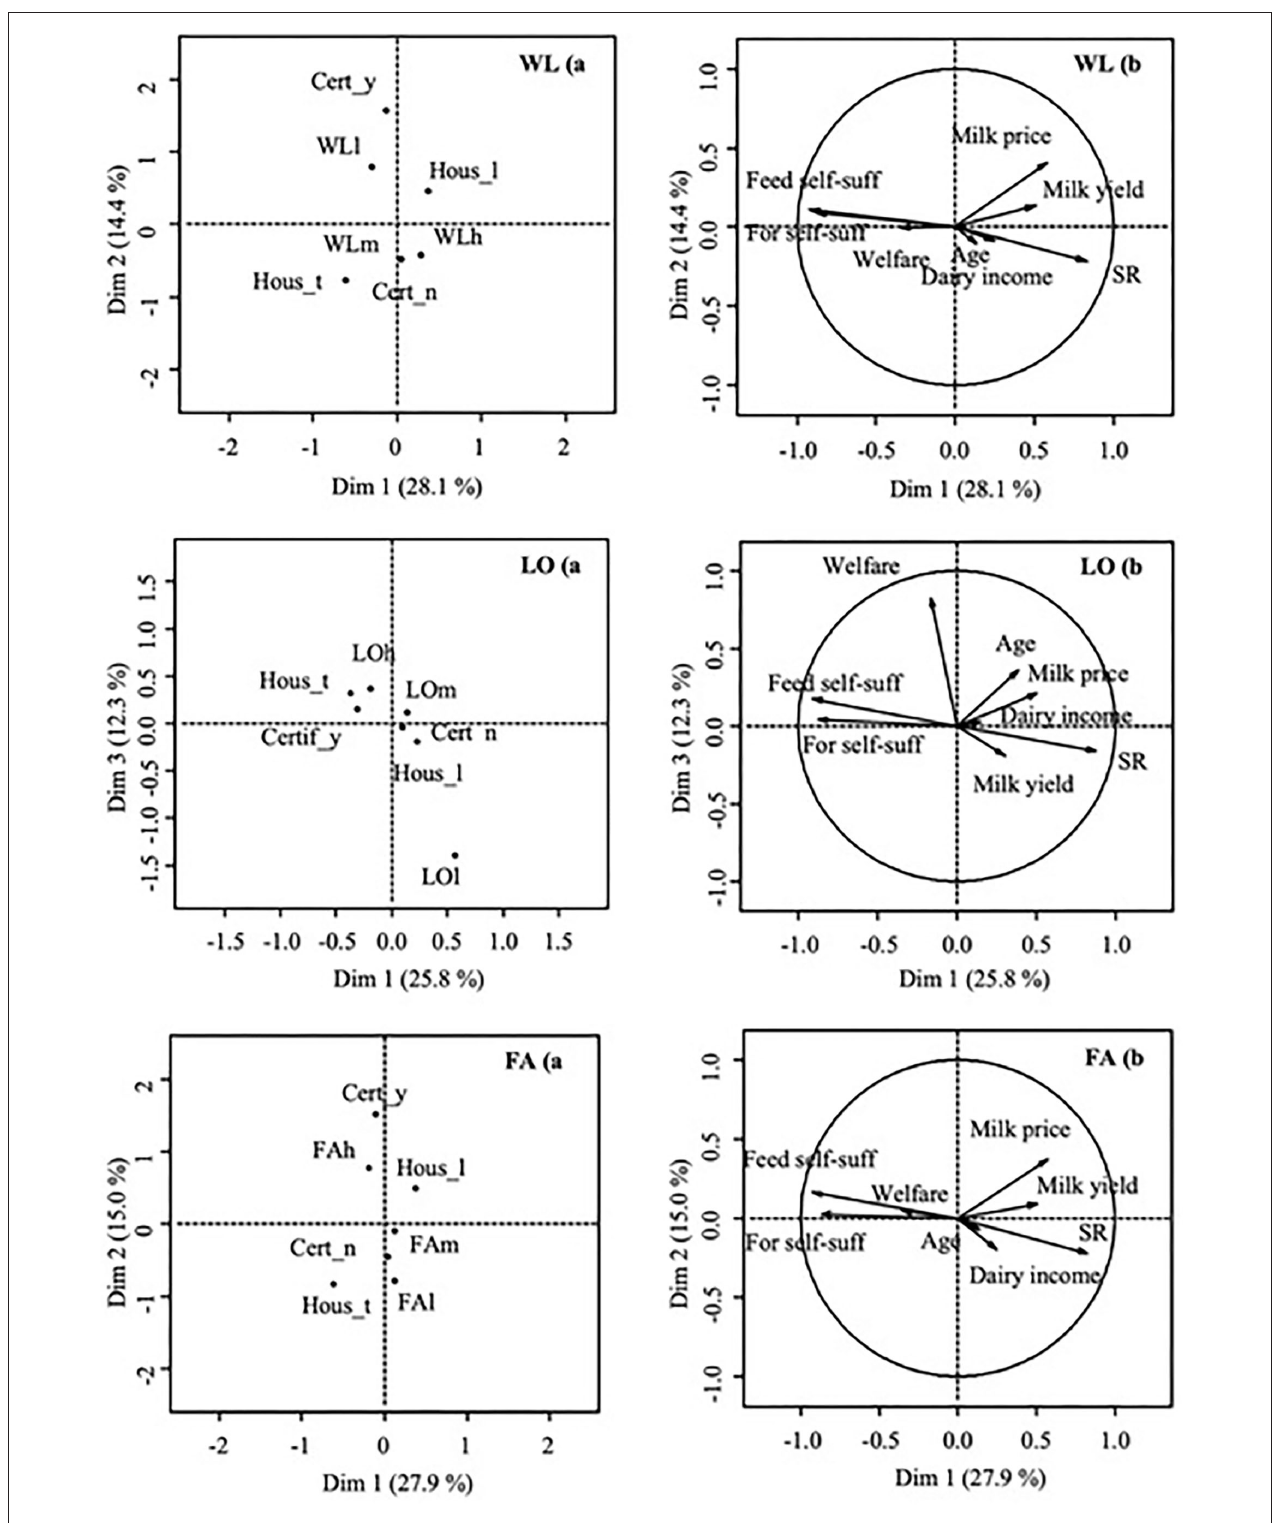
FIGURE 1 | Results of the PCA analysis for the variable related to farmers’ satisfaction (h: satisfied, m: neutral, l: unsatisfied) related to WL (amount of workload), LO (land organization), and FA (future of local agriculture); (A) : component map with factor scores of categorical variables; (B) : component map with factor scores of continuous numerical variables. Cert_y: farms with a certification; Cert_n: farms without certification; Hous_t: tie-stall barn; Hous_l: loose housing farms;